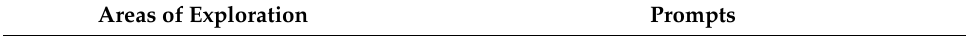
Table 1. Topic guide used for interviews after completion of steps summarised in Figure